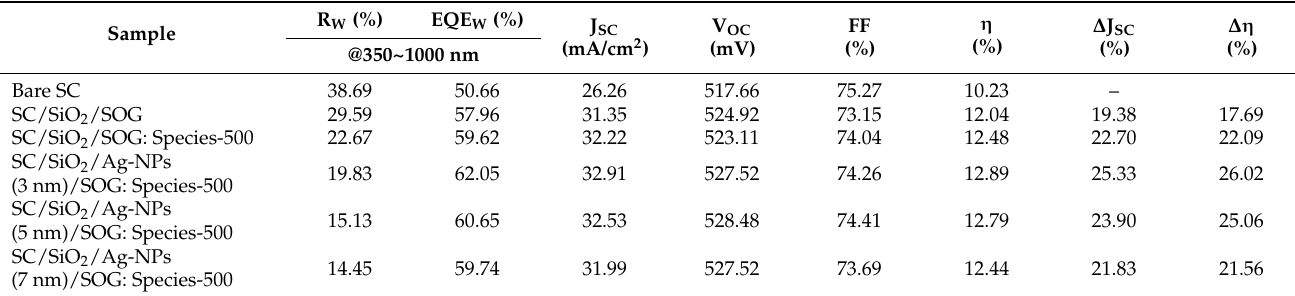
Table 3. Average weighted reflectance ( R W ), average weighted EQE ( EQE W ), and photovoltaic performance of all evaluated solar cells.